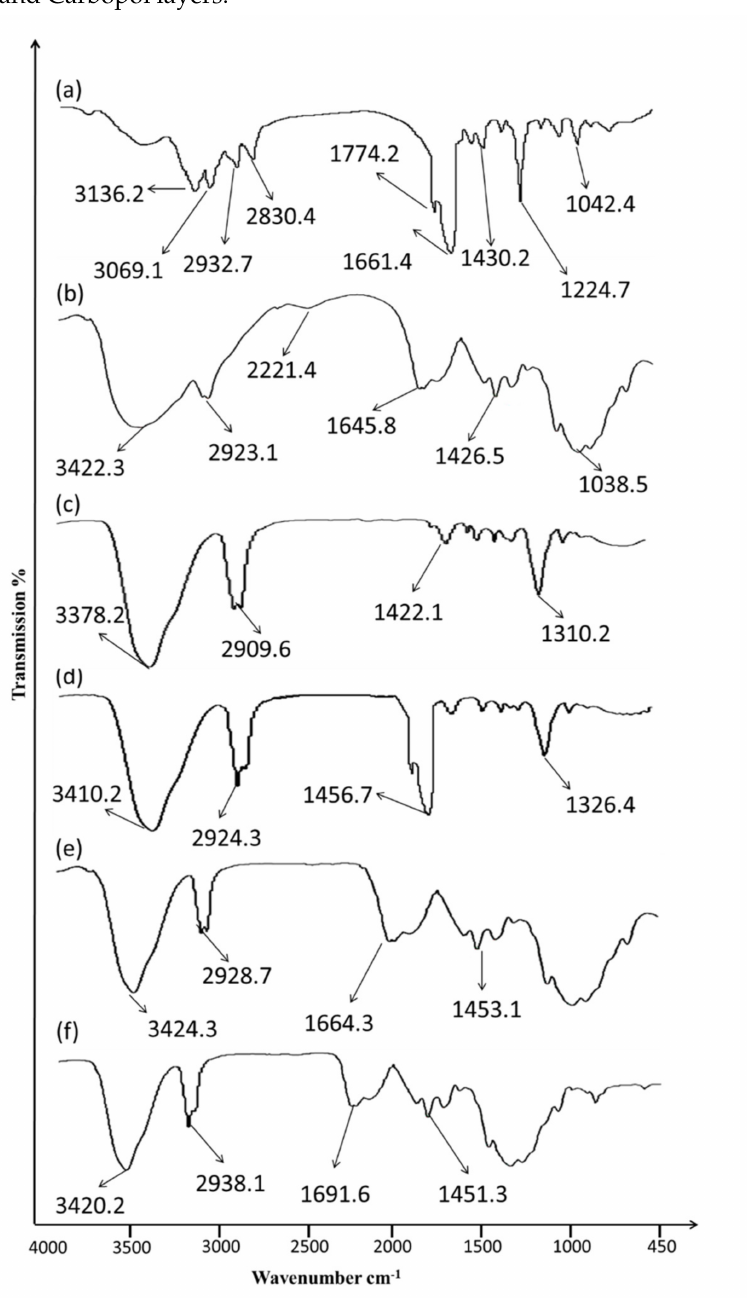
Figure 1. ATR − FTIR spectra of ( a ) 5-FU, ( b ) chitosan, ( c ) blank nanoemulsion ( d ) 5-FU-NE, ( e ) 5-FU- C-NE and ( f )